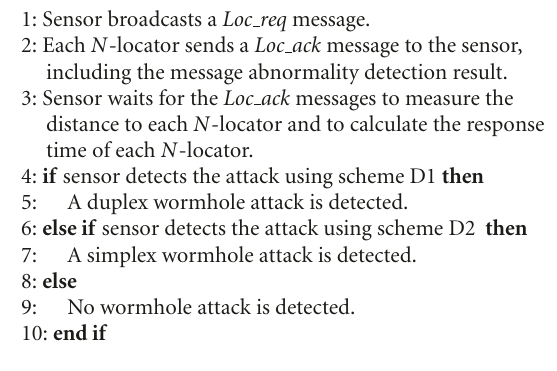
Algorithm 1: Wormhole attack detection